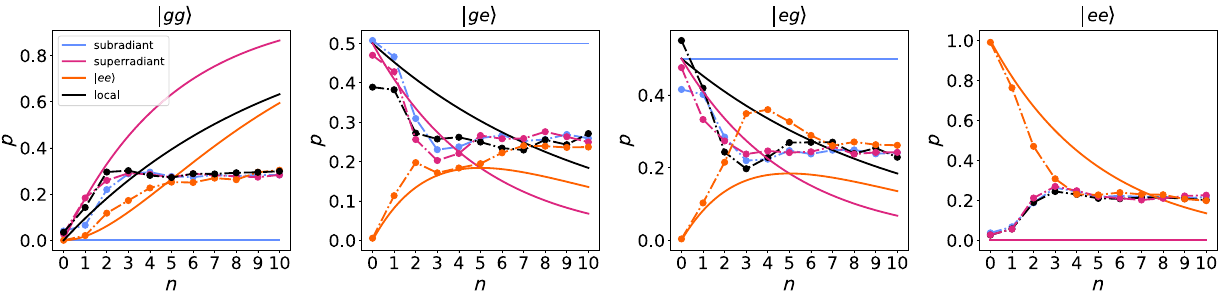
FIG. 12. The probability of finding the states | gg (cid:5) , | ge (cid:5) , | eg (cid:5) , and | ee (cid:5) (from left to right) through a projective measurement in the computational basis as a function of the number of steps in the MCM on IBMQ_GUADALUPE , when the initial state is the subradiant state (light blue), the superradiant state (magenta), and | ee (cid:5) (orange), and when the dynamics are local, starting from the subradiant state (black). The continuous lines show the theoretical prediction based on the master equation. The markers on the dash-dotted lines show experimental values. The reset gate is employed to refresh the state of the ancillary qubit after each time step.